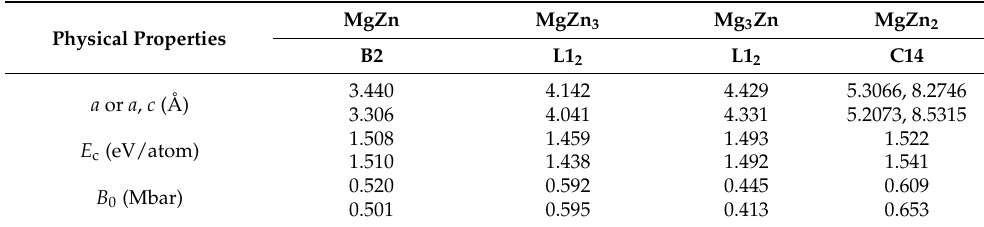
Table 4. The physical properties of the Mg-Zn intermetallic compounds fitted using the potential (first line) and obtained from experiments or ab initio calculations (second